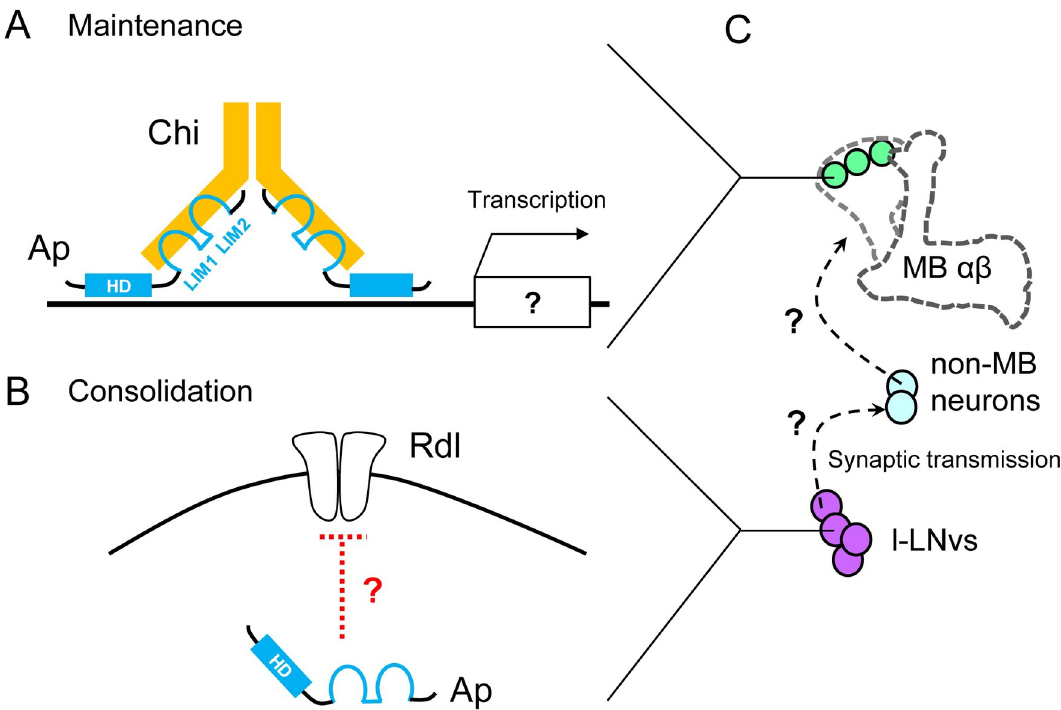
Fig 10. Possible model of Ap functions in the consolidation and maintenance of LTM. (A) The Ap/Chi complex induces gene expression. Subsequently, proteins required for maintaining consolidated LTM are produced in MB α / β neurons. (B) In l-LNvs, Ap may inhibit GABA responses via Rdl in a Chi-independent manner. (C) Intercellular communication from l-LNvs to MB neurons plays a crucial role in forming stable LTM. Non-MB neurons may mediate intercellular communication between l-LNvs and MB neurons. Ap, Apterous; Chi, Chip; GABA, gamma-aminobutyric acid; l-LNv, large ventral–lateral clock neuron; LTM, long-term memory; MB, mushroom body.